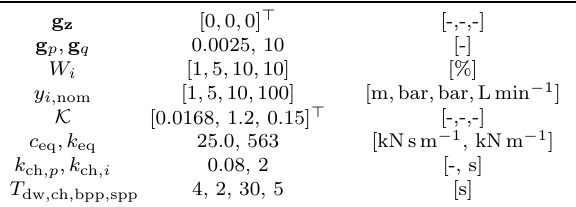
Table 4: System parameters.